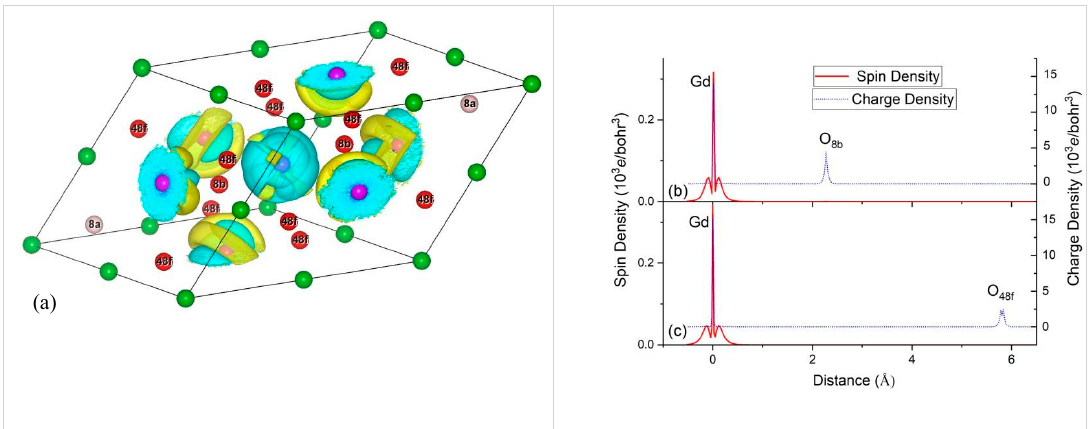
Figure 8. ( a ) The OP-GHO spin density isosurfaces. Isodensity surfaces of 0.0015 e /bohr 3 are displayed. Lines show the unit cell boundaries. Colors are atoms (Green = Hf; Purple = Gd; Red = O; Pink = O ghost atom). The O sites are shown. Yellow and cyan represent spin-up and -down cases, respectively. ( b , c ) represent the spin and charge density profiles. Charge density peaks denote nuclear positions.